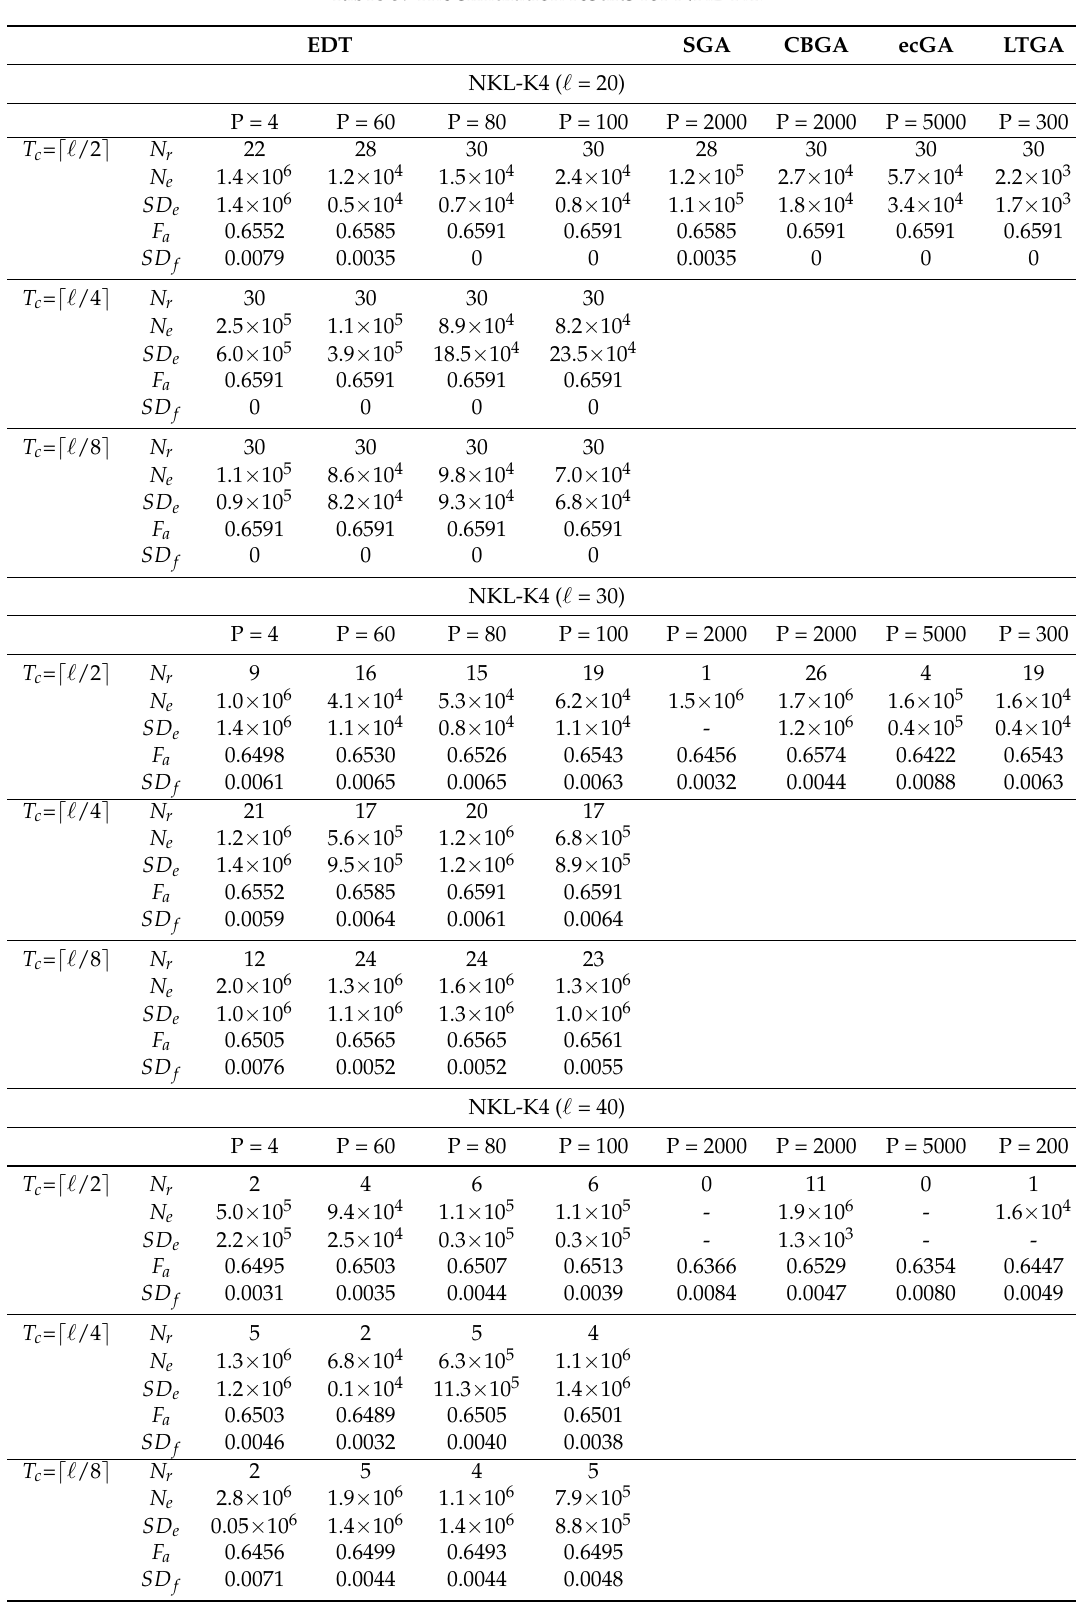
Table 5. The simulation results for